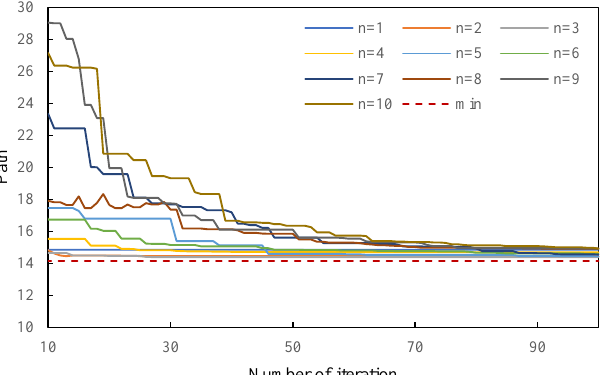
Figure 8. Convergence curves of optimal fitness values based on IPSO-IDE with n (n = 1–10) path nodes under the environment 1.